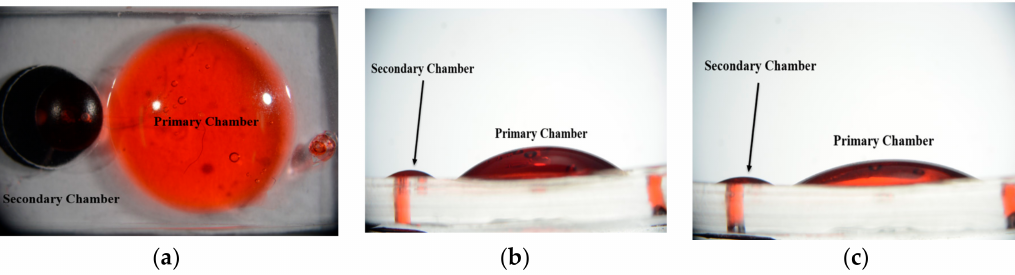
Figure 10. Image of the actual device. ( a ) Top view of the device. The primary chamber and the secondary chamber is labeled. ( b ) Side view of the device with primary chamber filled with 270 µ L of dyed DI water. ( c ) Side view of the device with primary filled with approximately 190 µ L of dyed DI water after 8